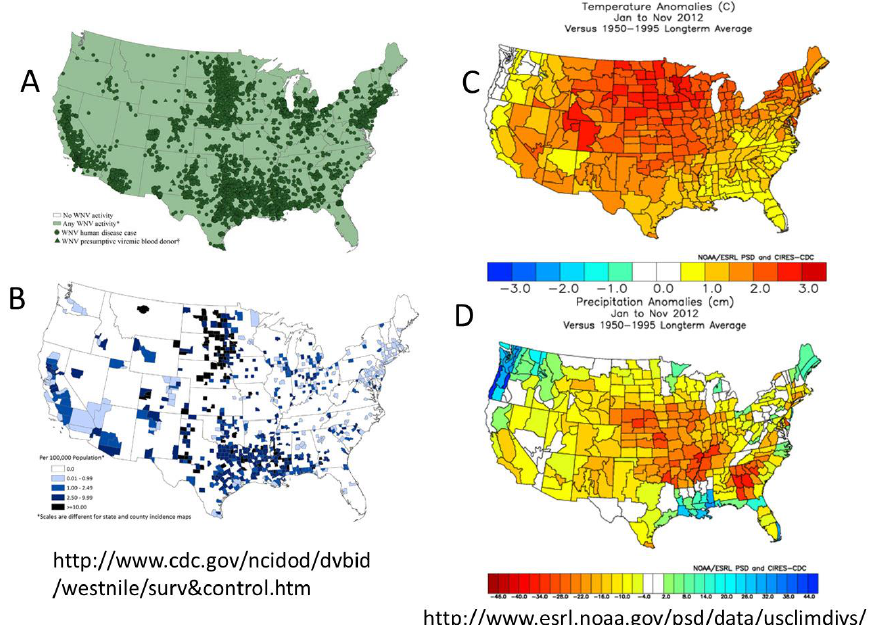
Figure 3. West Nile virus activity and climate analomies in the USA during 2012.